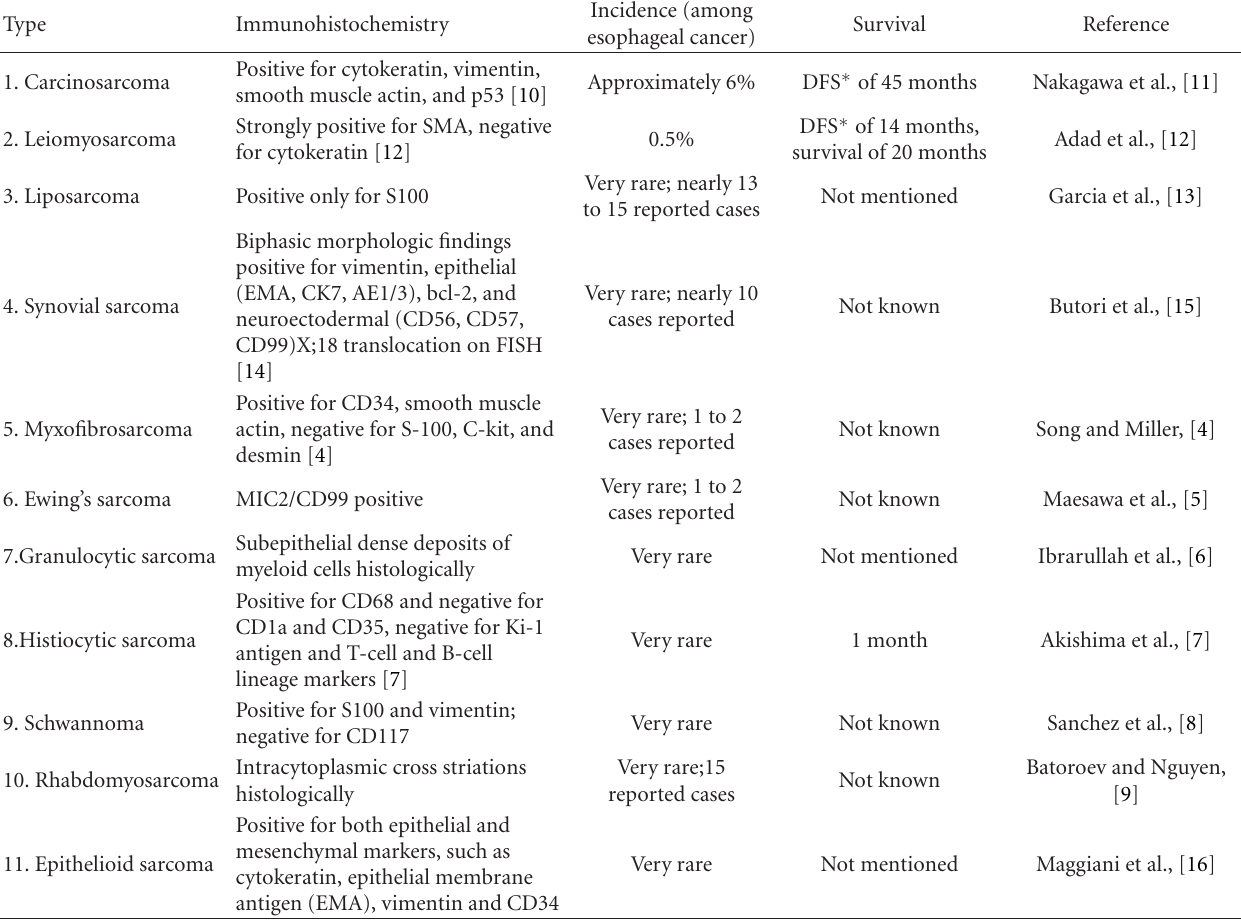
Table 1: Morphological variants of esophageal